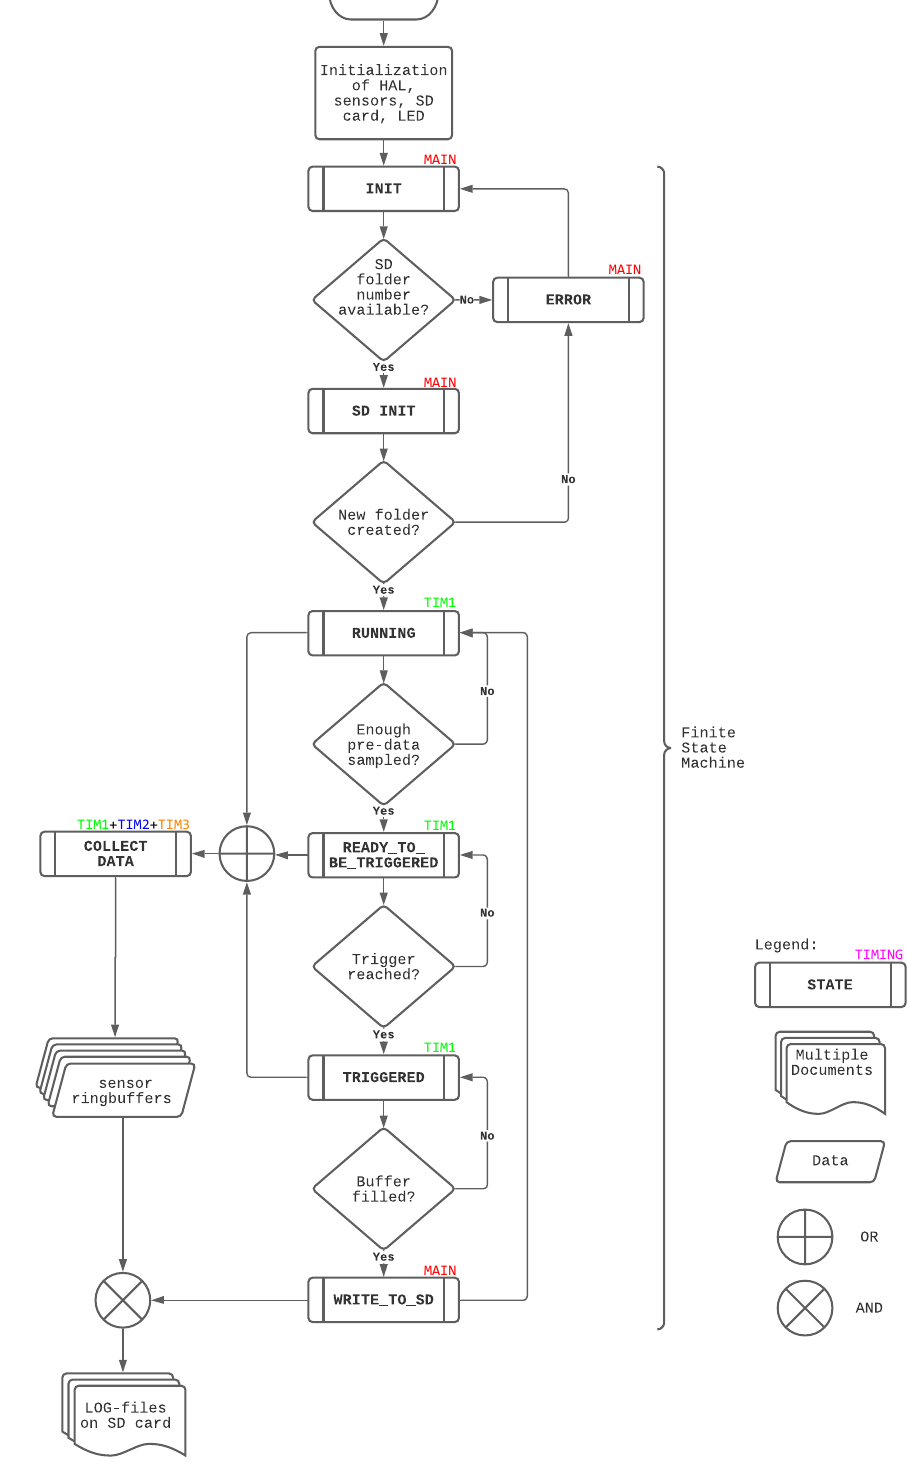
Figure 3. Flowchart of the state machine running on the microcontroller. Note that there is an annotation about the location of the